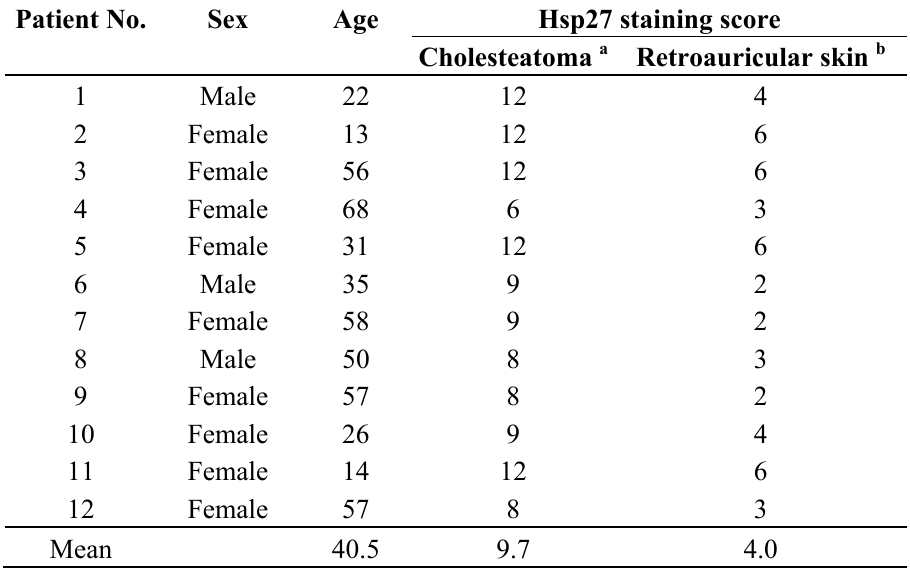
Table 2. Statistical characteristics of patients with cholesteatoma and the staining scores of HSP27 for the twelve patients. Paired t -test: a b p < 0.05 . Patient